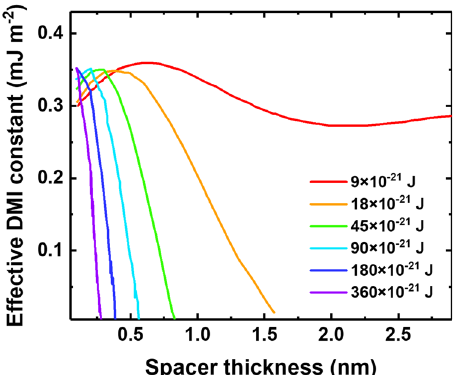
Fig. 5 Theoretical estimation of the in fl uence of the spacer energy range on iDMI. Each color represents a different E F − E c,spacer value. As the spacer becomes more conductive, the value of E F − E c,spacer increases. This approximate estimation is close to the energy range associated with a full screening with a spacer thickness equal to 0.3 nm, which is consistent with the experimental data for Co/Au/Pt stack 20